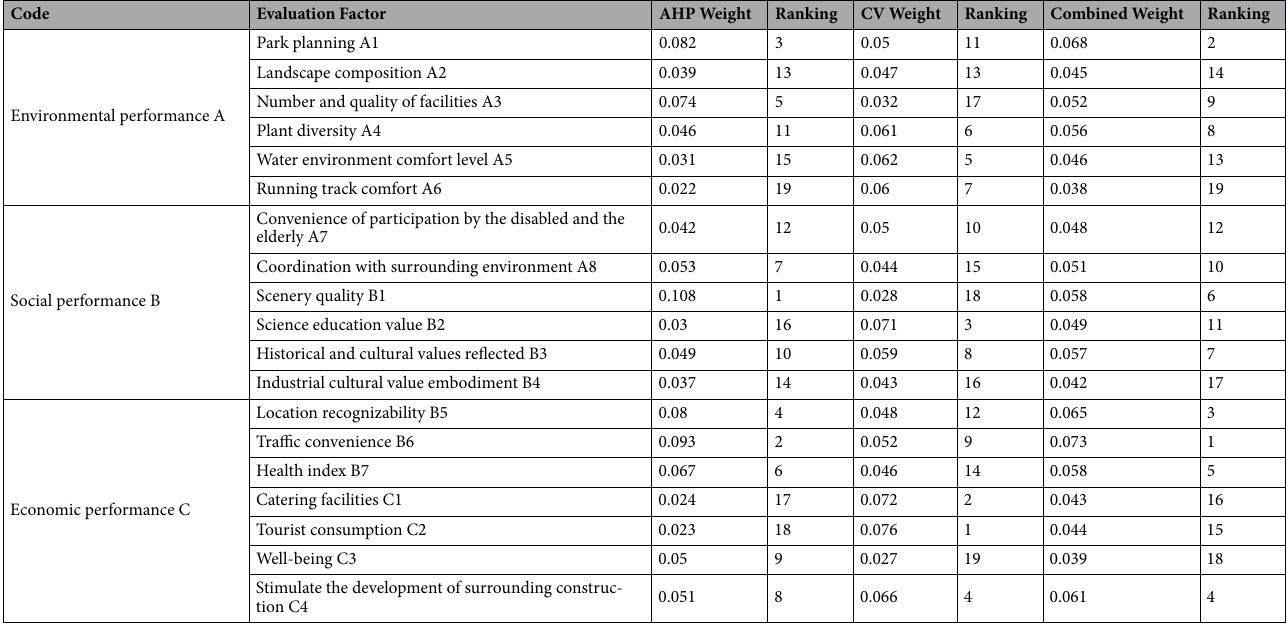
Table 3. Qingkou central park evaluation index weight and weight